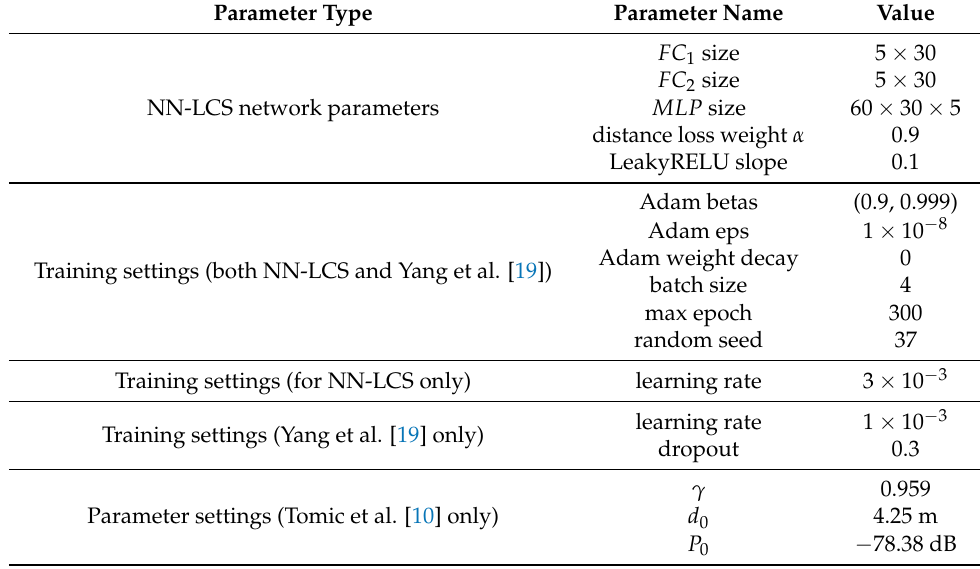
Table 3. Hyperparameters and settings for the NN-LCS and comparative methods. The parameters for the comparative methods listed here are the ones that we modified for the best performance on our dataset.